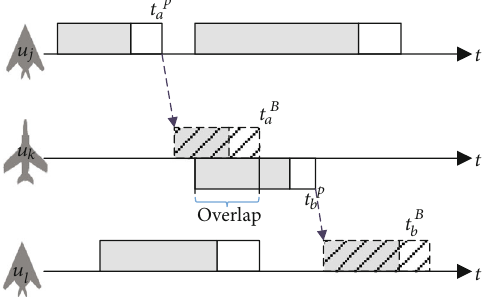
Figure 3: An example for BP overlapping. Figure 4: An example for BB